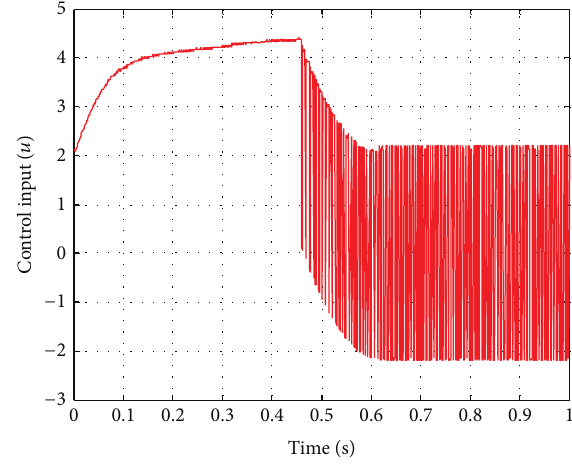
Figure 6: Phase portrait ( 𝑥 versus ̇𝑥 ).